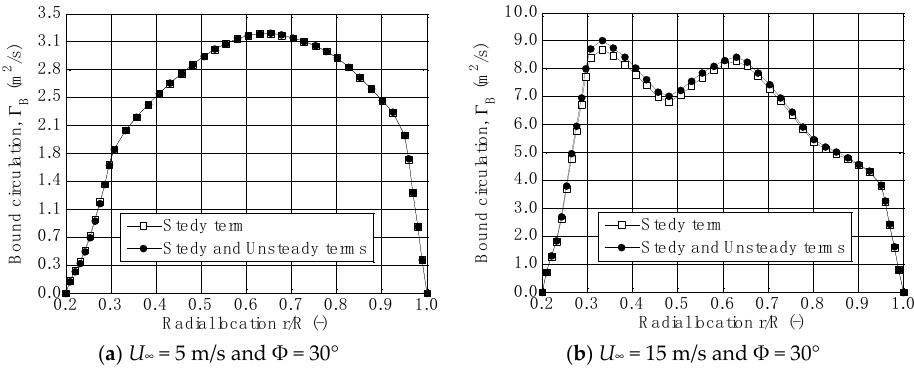
Figure 3. A case study showing the effects of excluding the unsteady term in the classic